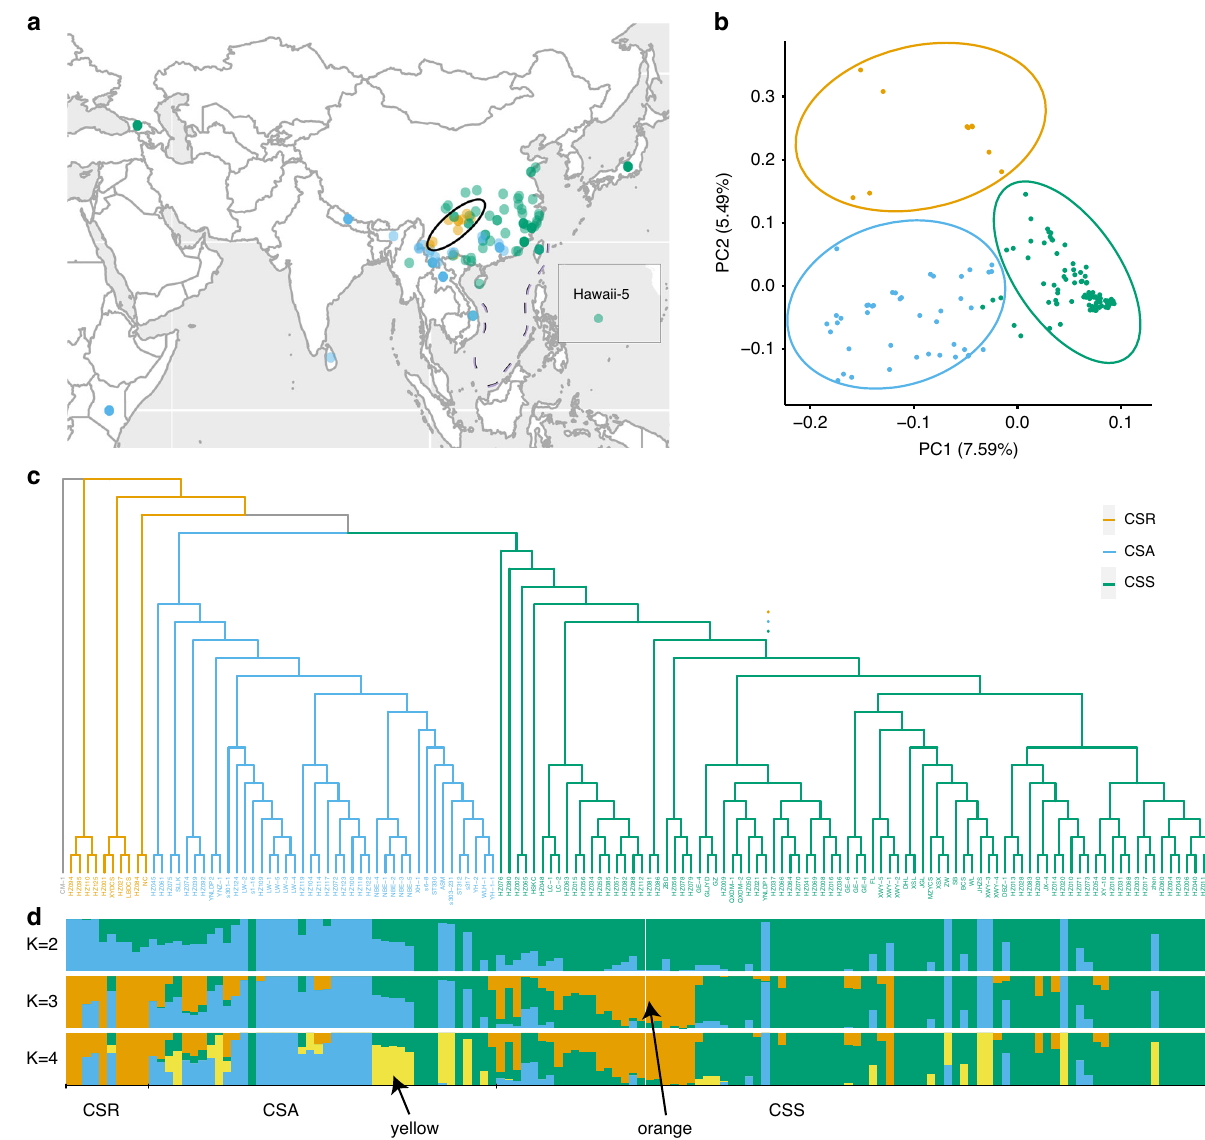
Fig. 2 Distribution and evolution of tea. a The distribution of tea accessions assessed in the present study. The teas within the black oval had the highest nucleotide polymorphism. b Principal component analysis of the tea populations. PC1 and PC2 split the tea populations into three clusters. The Camellia sinensis var. sinensis (CSS) samples were found to cluster more tightly than the C . sinensis var. assamica (CSA) samples. c A phylogenetic tree of tea. Camellia sasanqua Thunb. was used as the outgroup, and the tea samples closest to the outgroup were C. sinensis -related species (CSR). d Structure of the tea populations. Green, blue, and yellow represent the CSS, CSA, and CSR populations, respectively. Yellow and orange are marked with arrows. Source data are provided as a Source Data fi